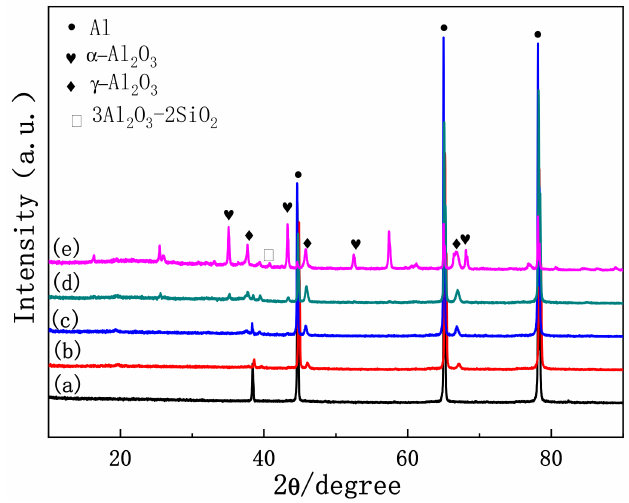
Figure 7. XRD patterns of PEO coatings at different stages: ( a ) stage I; ( b ) stage II; ( c ) stage III; ( d ) stage IV; ( e ) stage